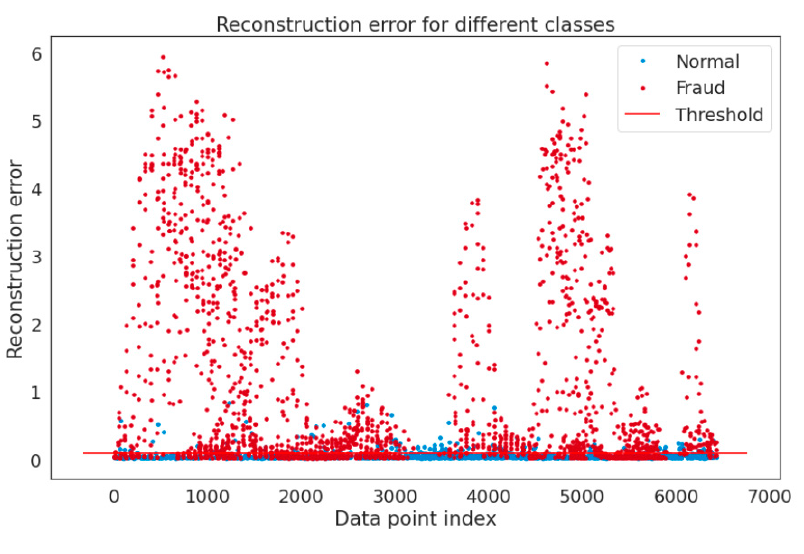
Figure 4. Different classes depicting reconstruction error.